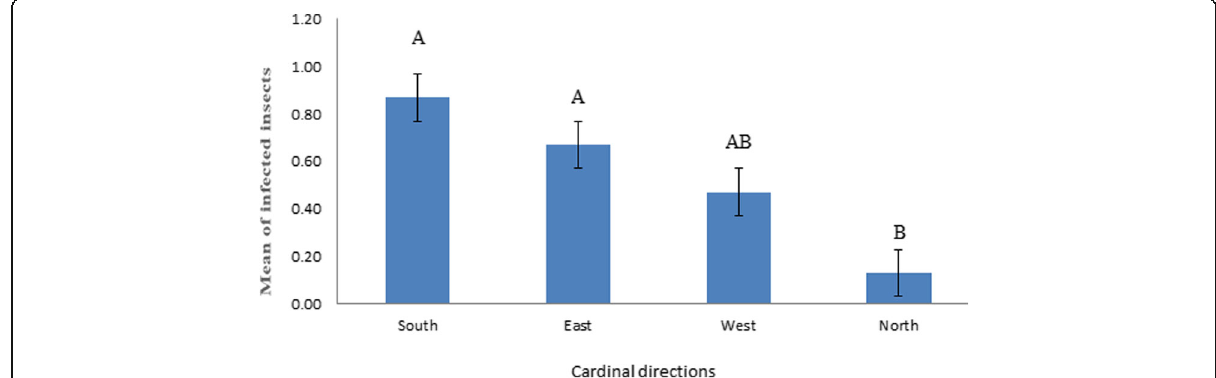
Fig. 3 Mean mortality of Galleria mellonella larvae (75 insects per 15 root systems in 5 strawberry beds for each direction in each of 3 times, a total of 900 baiting insects). Different letters above bars indicate statistical significance ( P ≤ 0.05) using